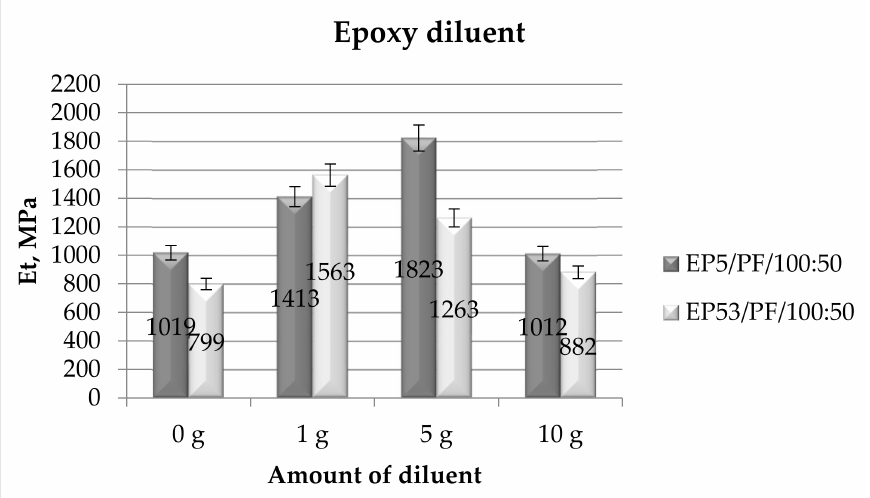
Figure 15. Tensile modulus calculated for Epidian 5 and Epidian 53 epoxy compounds as a function of the amount of epoxy